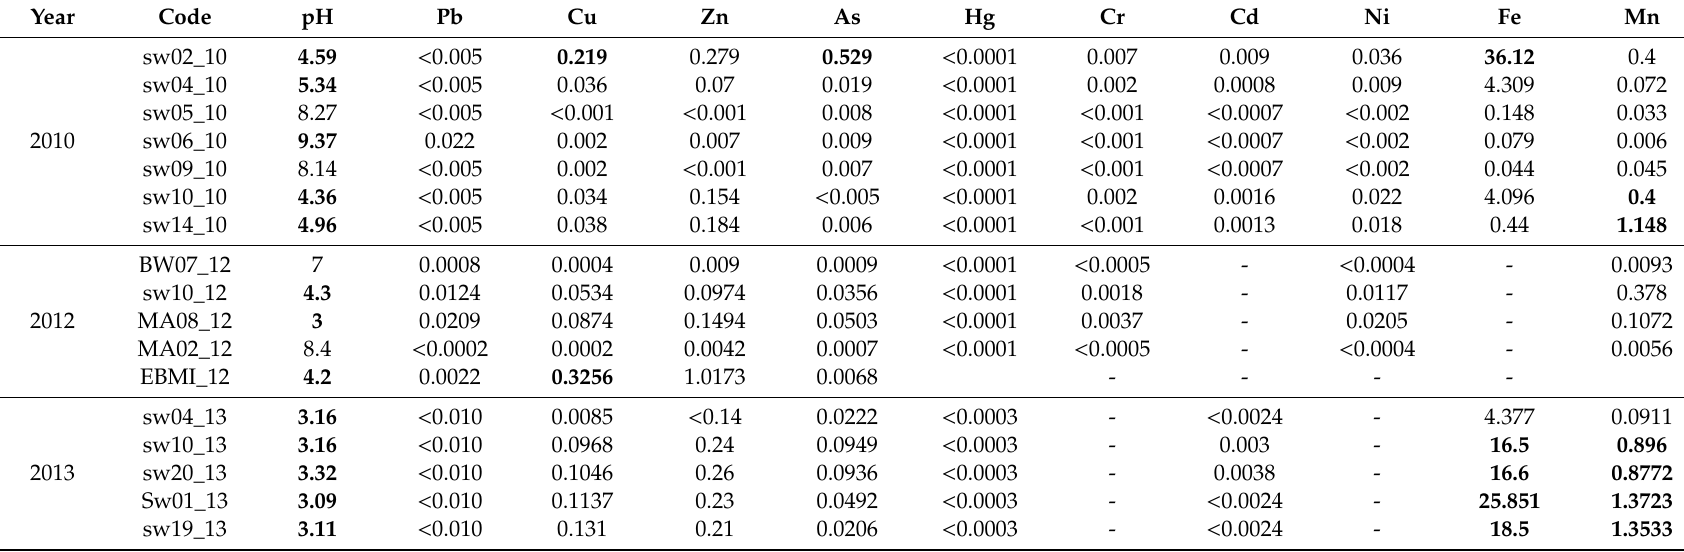
Table A1. Total metal concentrations (mg L − 1 ) in water samples evaluated by OEFA in Aimaraes sub-basin. Values exceeding EQS are in